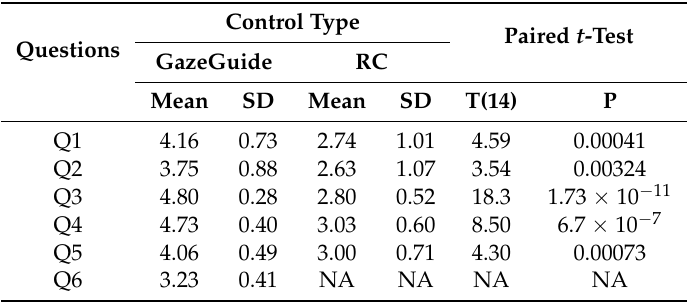
Table 5. Subjective questionnaire results (five-point scale: 1—strongly disagree, 2—disagree, 3—neutral, 4—agree, 5—strongly